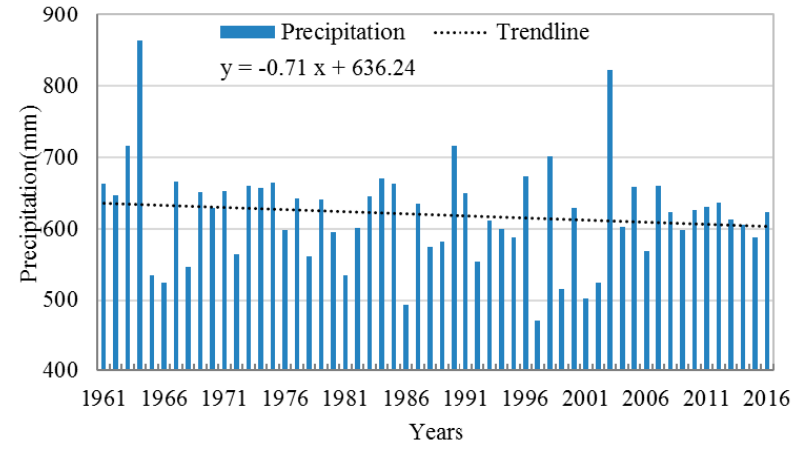
Figure 2. ( a ) Multi-year average precipitation; ( b ) Coefficient variance of precipitation in Huang-huai-hai River Basin.